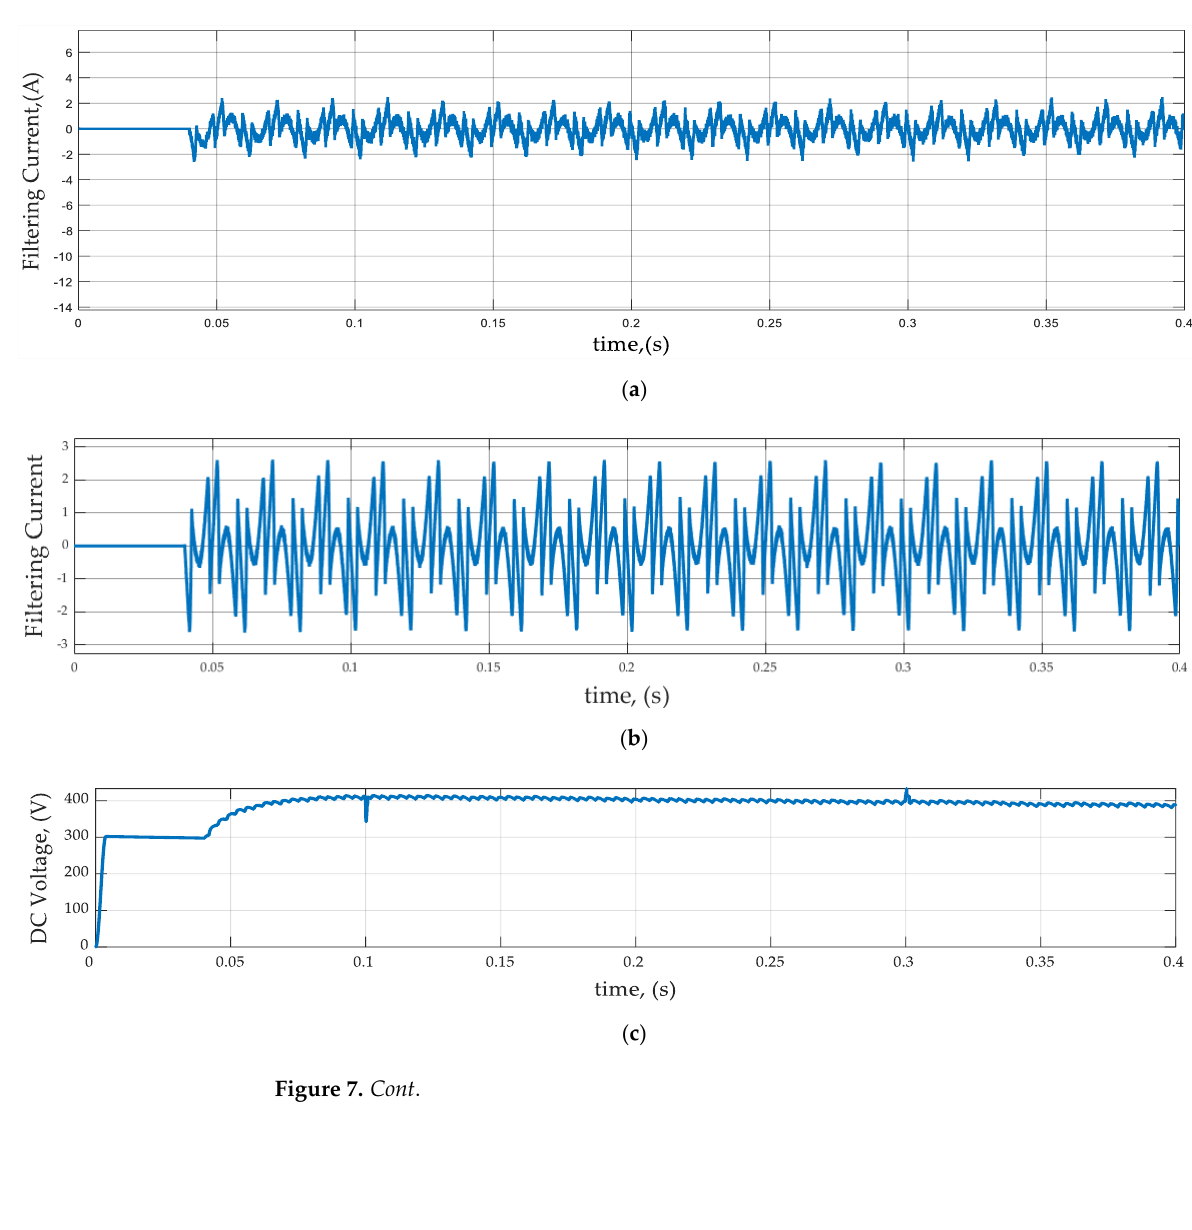
Figure 7. The switching current and DC voltage performance ( a ) the PI controller filtering output current, ( b ) the fuzzy-tuned PI controller filtering current wave shape, ( c ) the shunt capacitor volt- age response with PI controller, and ( d ) the shunt capacitor voltage response with fuzzy-tuned PI controller. On the other hand, Figure 7c,d shows the performance of the DC voltage. From Fig- ure 7c, it can be seen that the PI controlled HPF ’ s DC voltage starts late, and its perfor- mance is influenced by load variation. The DC voltage wave produces spikes when the load changes, and while the MATLAB test did this by changing the load only two times, these changes would happen frequently on the real distribution line. Thus, the loads would receive frequent spiking waves, which could damage the customers’ equipment.